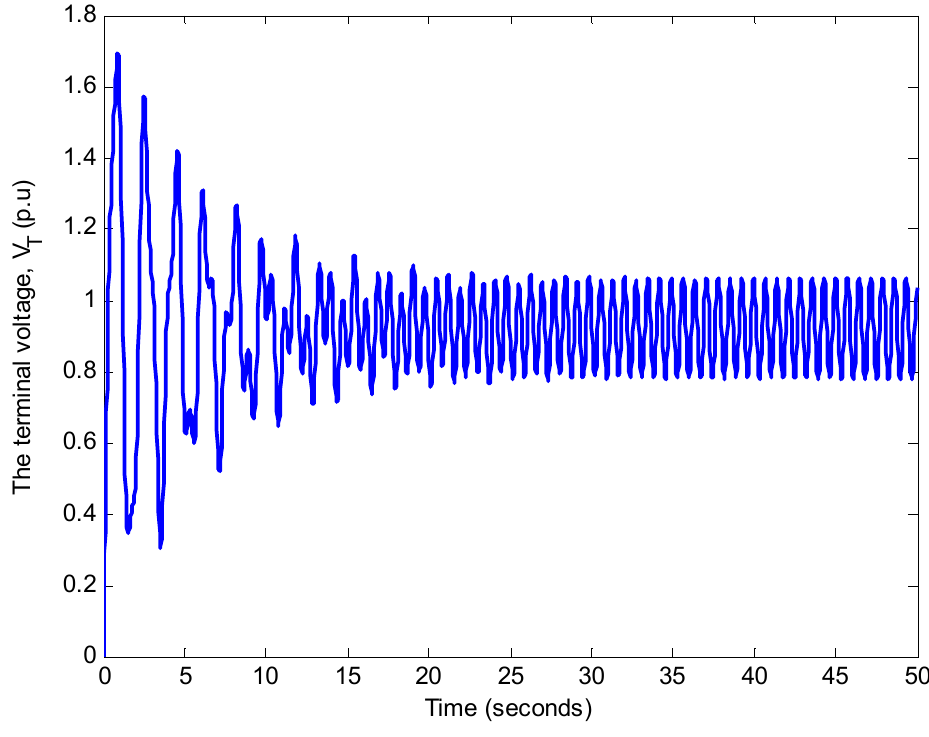
Figure 18. The terminal voltage with a 0.3 s time delay.